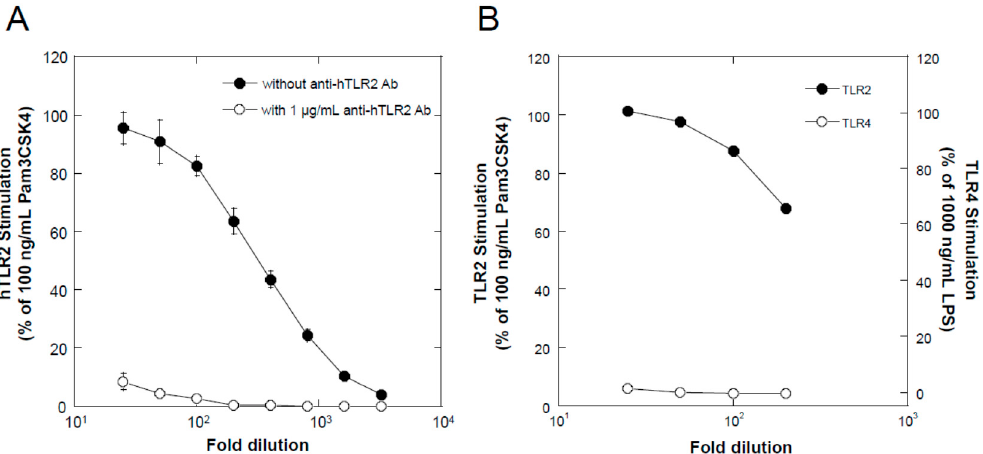
Figure 6. ( A ) TLR2-stimulating activity of the culture supernatant after jar fermentation. Instead of static culture conditions, jar fermentation with mild stirring (80 rpm) was employed for the fermentation of TL24 in asparagus/milk medium at 37 ° C for 24 h. After heat treatment at 110 ° C for 20 min, the culture supernatant was collected, and its TLR2-stimulating activity was examined (closed circles). To determine whether this activity occurred due to the stimulation of TLR2, the effect of a TLR2 neutralizing antibody was examined at a concentration of 1 µg/mL (open circles). (n = 3; mean with S.D.). ( B ) TLR2- and TLR4-stimulating activities of the culture supernatant after jar fermentation. In addition to the TLR2-stimuating activity (closed circle), TLR4-stimulating activity was examined (open circle). (n = 1).